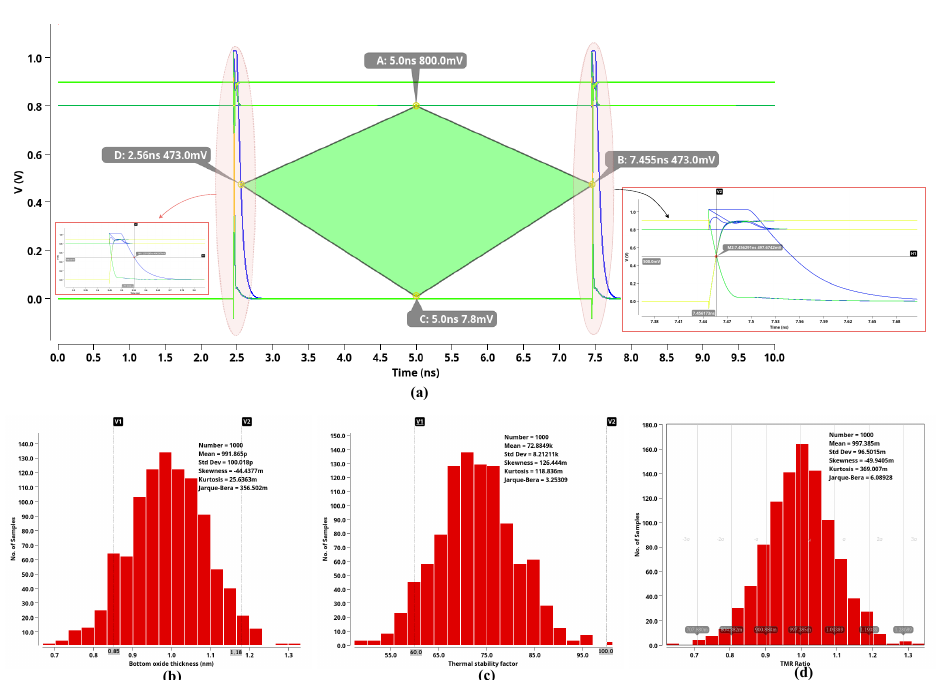
Figure 5. ( a ) Eye diagram test with mask; ( b ) Monte Carlo simulation results for variation in bottom oxide thickness; ( c ) Monte Carlo simulation results for variation in bottom oxide thickness; ( d ) introduced Variation in TMR ratio for analyzing the tolerance of the LL